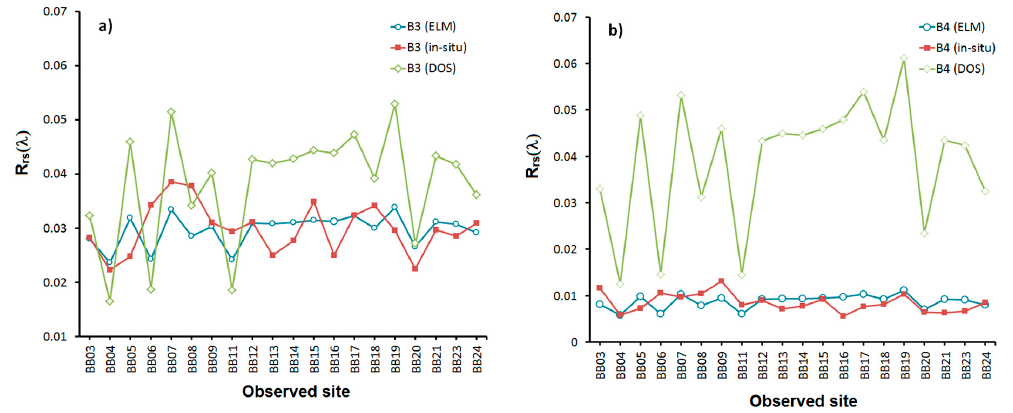
Figure 5. Comparisons between in situ, DOS and ELM output reflectances of band 3 ( a ) and band 4 ( b ) show the suitability of the ELM method for removing atmospheric effects.